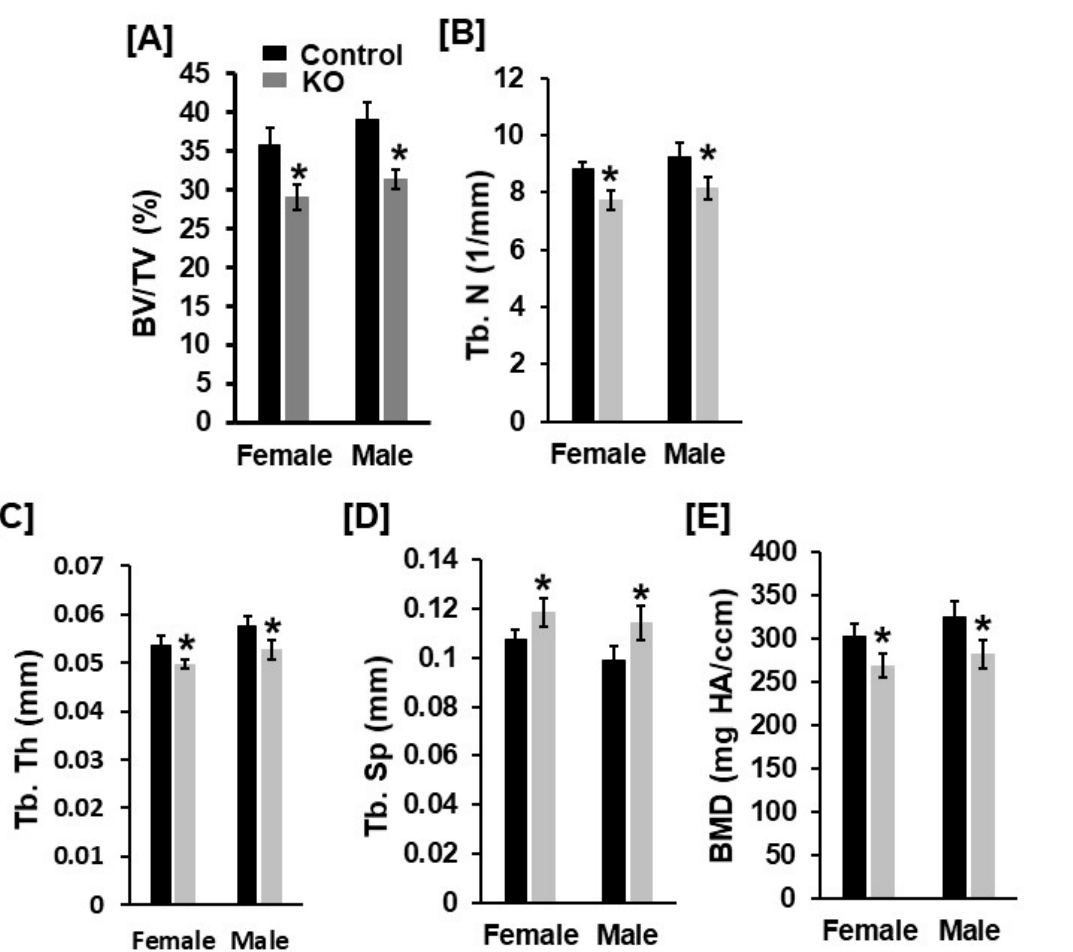
Figure 2. Mice with disruption of Tspan3 exhibit low bone mineral density in the proximal tibias. ( A – E ) Quantitative micro-CT data of the trabecular bone of the proximal tibia. TV, tissue volume; BV, bone volume; Tb. N, trabecular number; Tb. Th, trabecular thickness; Tb. Sp, trabecular spacing; vBMD, volumetric bone mineral density. Values are mean ± SEM (n = 7–9). *: p < 0.05 as compared to the control littermates.